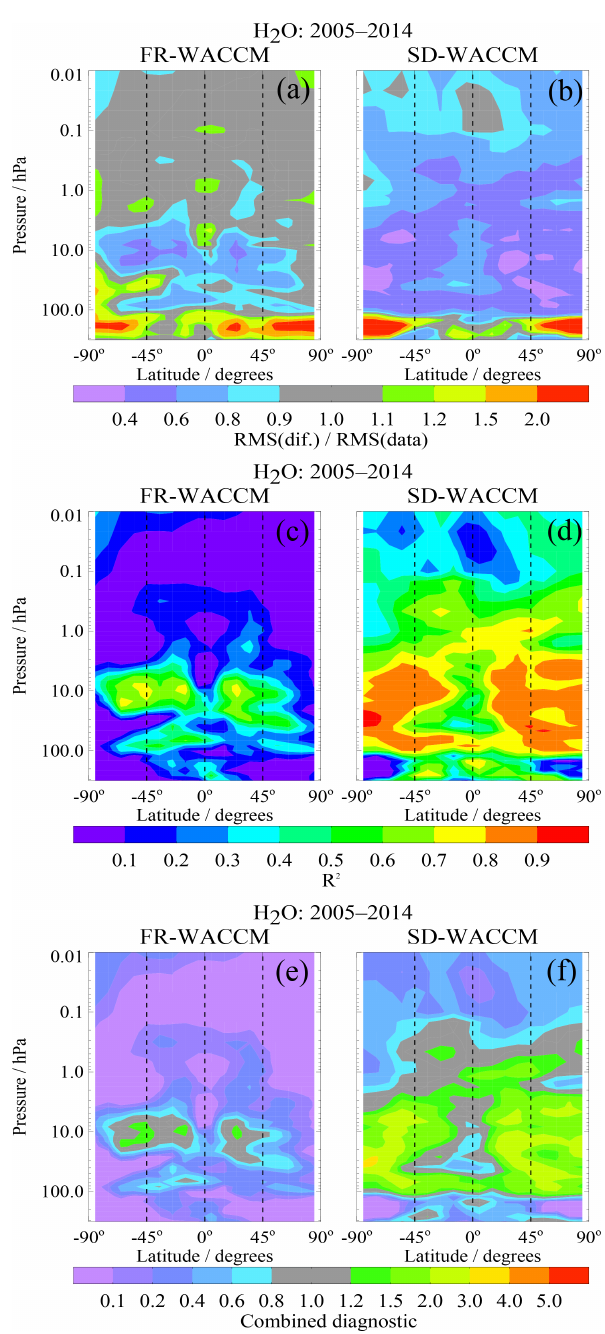
Figure 12. Same as the Fig. 10 diagnostics but for H 2 O up to 0.01hPa.